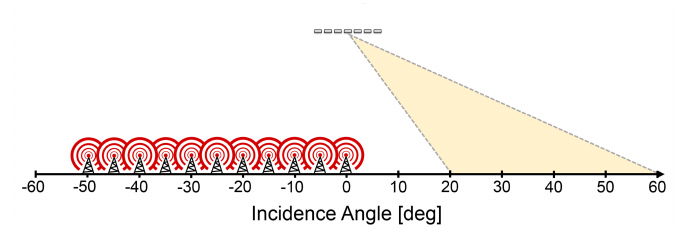
Figure 20. Scenario C: 11 interferers are present and outside of the swath. Locations range from − 50° to 0° in 5° intervals. Transmitting frequencies range from − 60 MHz to 25 MHz in baseband with 5 MHz